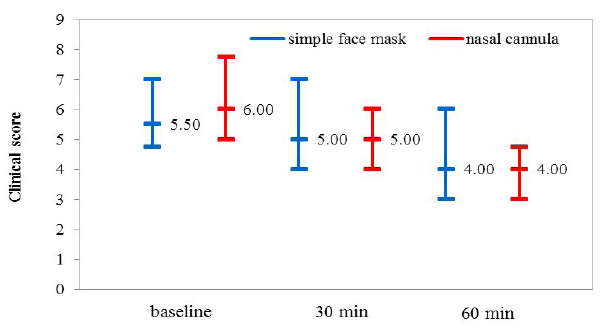
Fig. 1. The clinical score in moment 0 (baseline), and 30 min- utes and 60 minutes after oxygen therapy by simple face mask (blue) and by nasal cannula (red). The middle points represent the value of median while the extreme points are the 25 th and 75 th percentiles